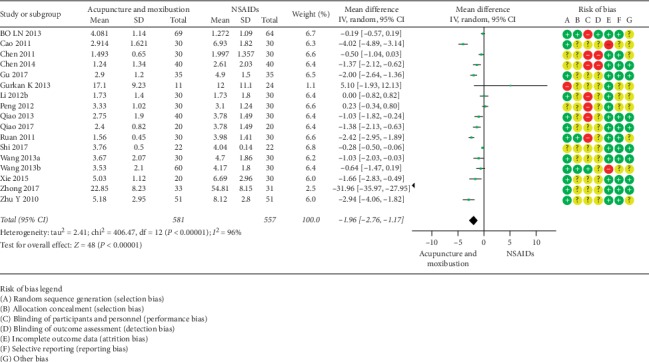
Acupuncture and moxibustion vs. NSAIDs.